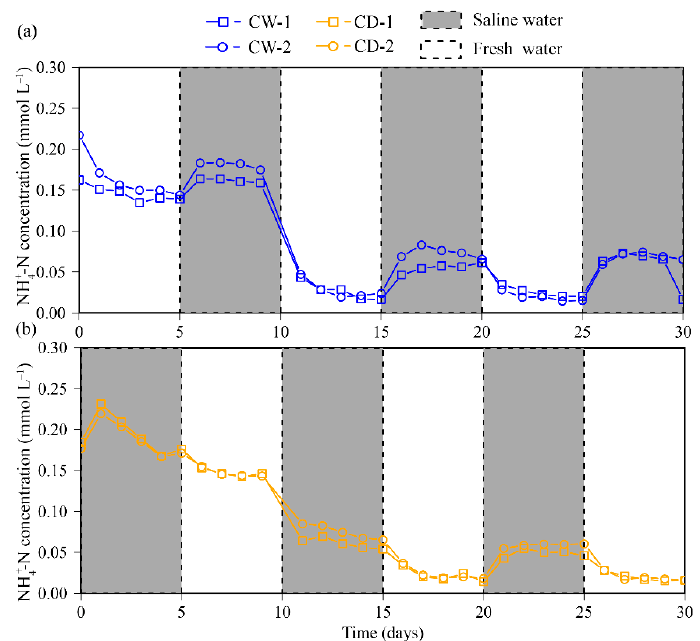
Figure 5. Ammonium (NH 4 + -N) release from peat soils under saline–fresh water cycles: ( a ) coastal rewetted, CW; and ( b ) coastal drained, CD.